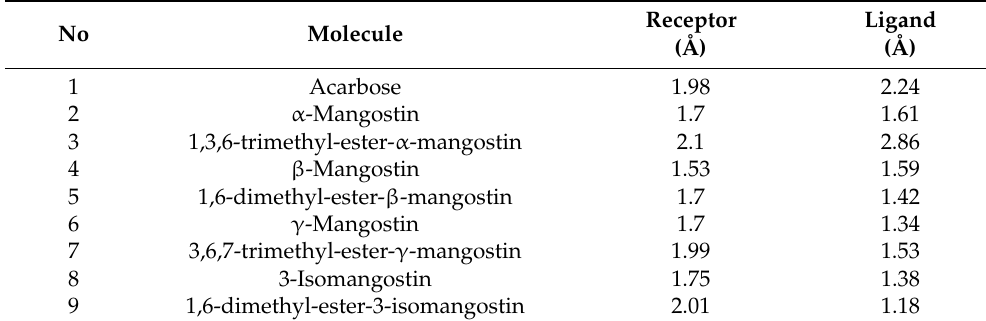
Figure 2. The intermolecular interaction between the compound 1,6-dimethyl-ester-3-isomangostin ( a ) and acarbose ( b ) with α -glucosidase enzyme. The 1,6-dimethy l-ester-3-isomangostin compound has a more diverse type of interaction than acarbose, especially at amino acid ASP616. 1,6-dimethyl- ester-3-isomangostin uses the pi-cation interaction to bind to the amino acid ASP616, whereas acarbose uses the Conventional Hydrogen Bond interaction to interact with ASP616. Table 3. RMSD value of the molecular dynamics simulation production stage for 100 ns. The average RMSD value was taken from 20,000 frames that were successfully formed during the production stage of the molecular dynamics simulation. The receptor is an α -glucosidase enzyme, and its ligand binds to the